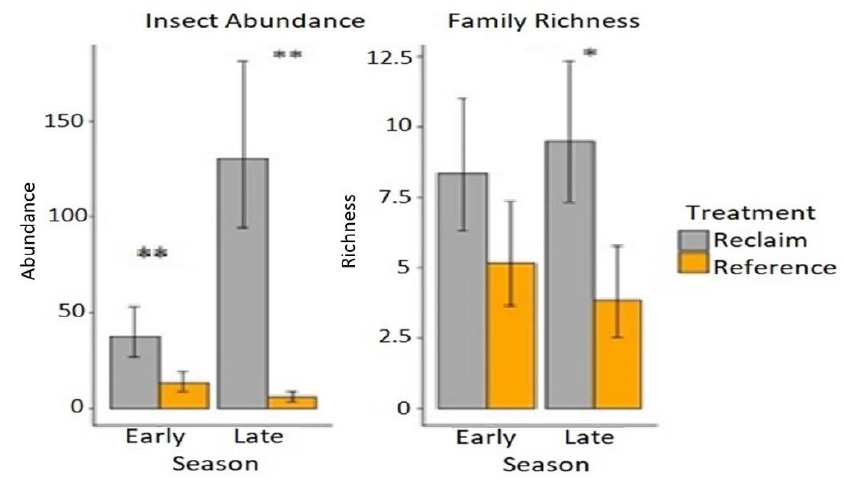
Figure 2. A graphical representation of species abundance (left) and species richness (right) compar- ing reference vs. reclaimed within early season and within late season (abundance; p -value <0.0001 ** & richness; p -value < 0.05 * (Late); p =0.2019 (Early). While mean insect family richness was higher on early season reclaimed sites (8.33) than reference sites (5.17), the difference was not statistically significant. However, mean Shannon Diversity Index values were significantly higher ( p = 0.038) on early season reclaimed sites (H = 1.74) than reference sites (H = 1.42). In the late season, mean insect family richness on reclaimed sites (9.5) was significantly higher than reference sites (3.83, p = 0.036). These findings are corroborated by family richness accumulation curves which show overlapping error bars when comparing early season reclaimed sites to early season references sites, but no overlapping error bars when comparing late season reclaimed sites to late season reference sites (Figure 3).